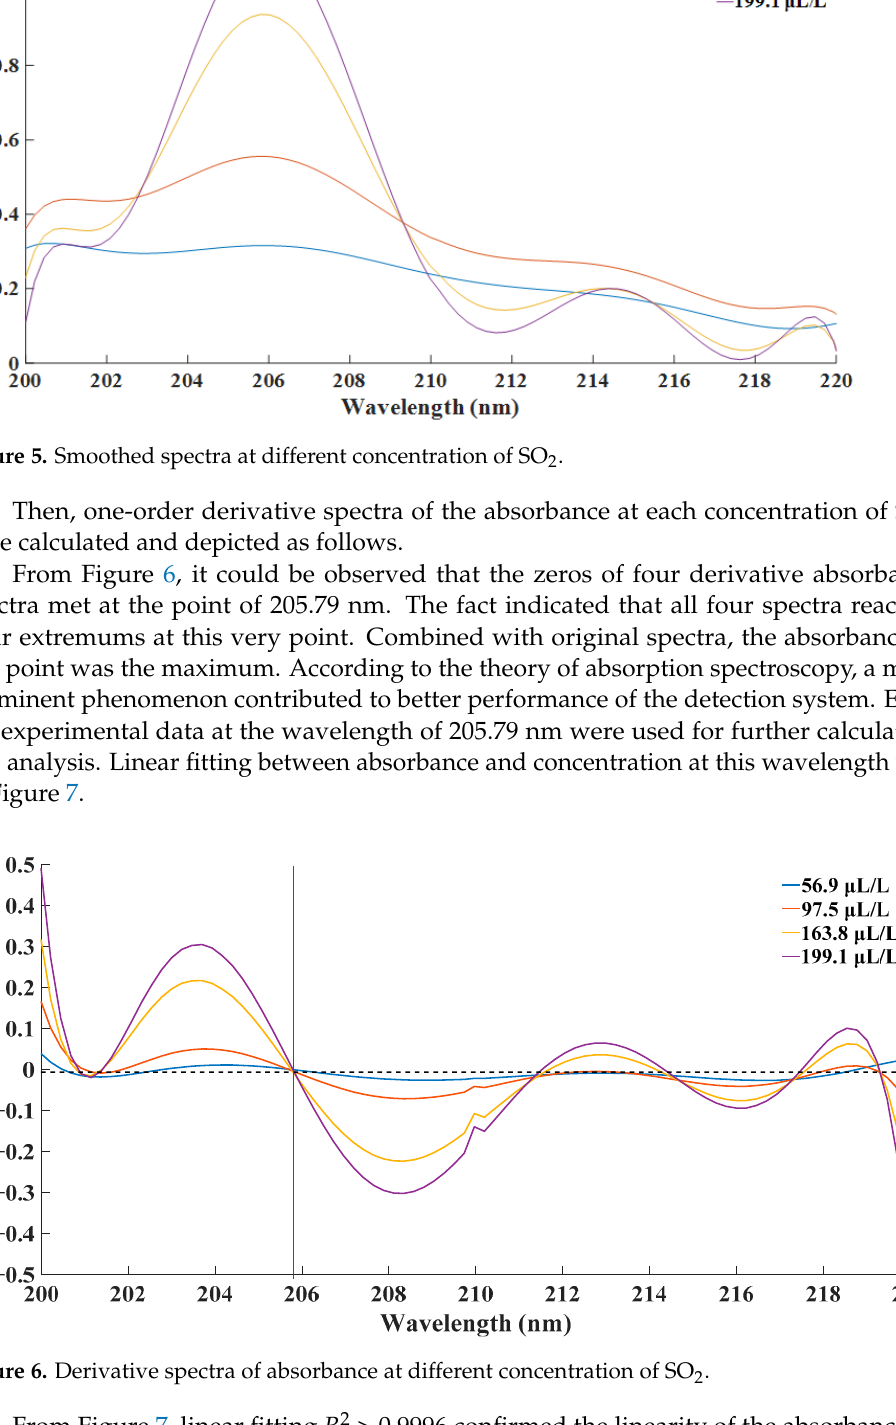
Figure 7. Linear fitting between absorbance and concentration. From Figure 7, linear fitting R 2 > 0.9996 confirmed the linearity of the absorbance re- sponse to the concentration of SO 2 . Moreover, the linear fitting function could be ex- pressed as follows.